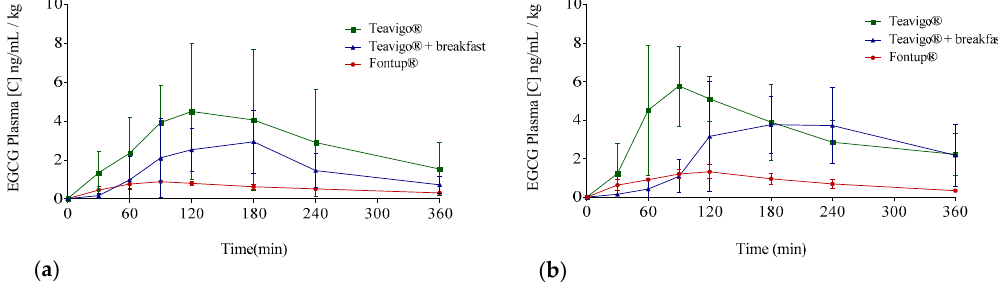
Figure 4. Averages of EGCG plasma concentrations over time distributed following EGCG preparation and gender: Teavigo ® condition is shown in green lines, Teavigo ® plus breakfast is in blue lines, and FontUp ® is in red lines. ( a ) EGCG average concentrations for men and ( b ) EGCG average concentrations for women. Error bars represent the standard deviation.